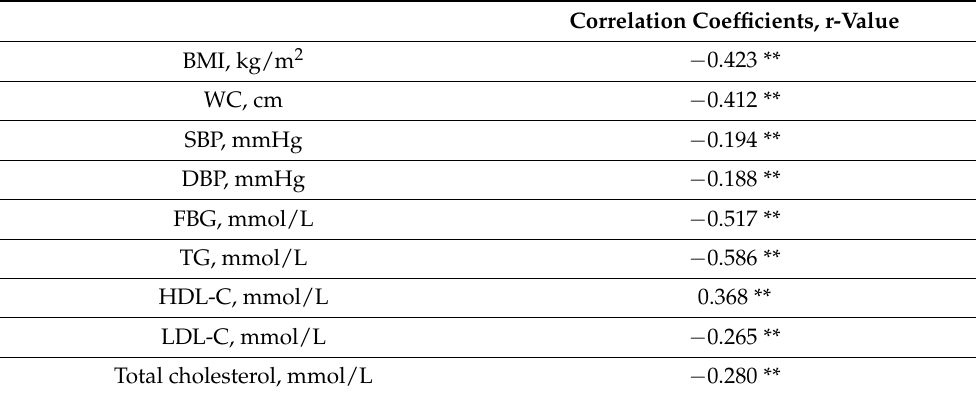
Table 5. Spearman’s correlations with serum magnesium level as the dependent